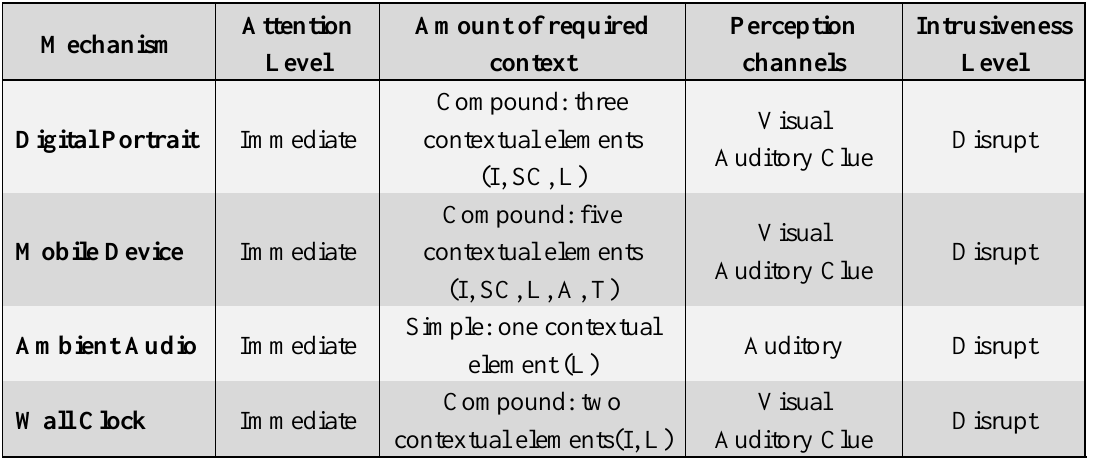
Table 1. Design features of the CANoE-Aw Notification Mechanisms implemented.